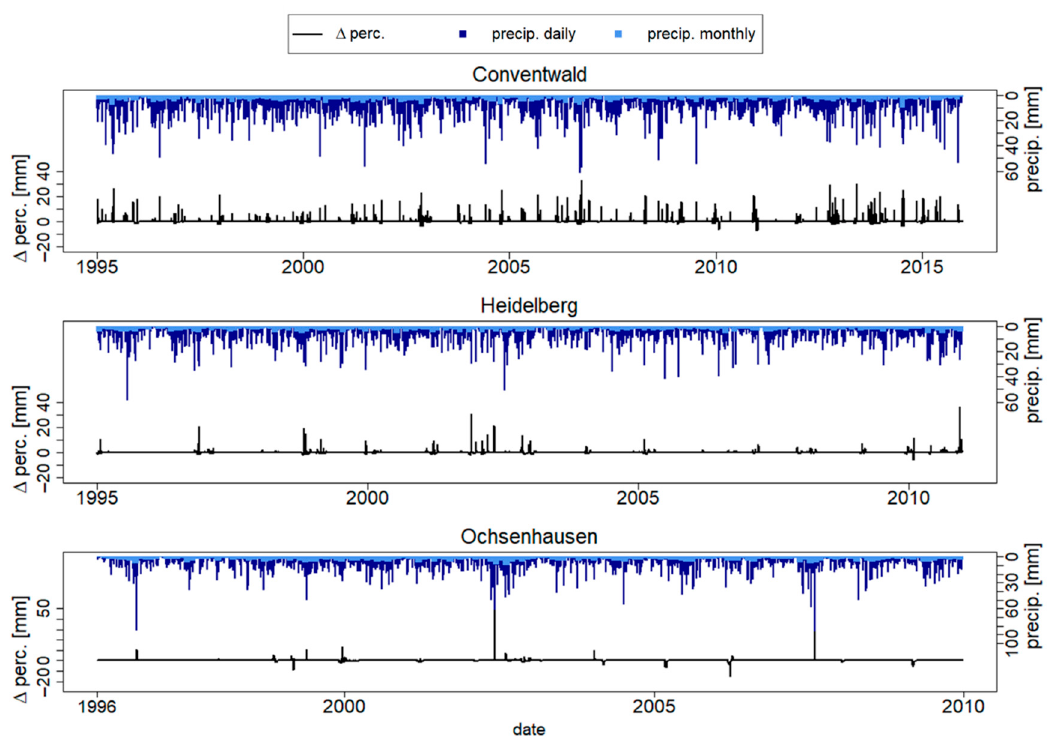
Figure A4. Variation of percolation from ER to DR ( PC ) due to daily or monthly calculation resolution, where ∆ perc. (mm × day − 1 ) is the difference between the simulated percolation with daily and monthly resolution. Monthly precipitation (precip. monthly, mm × day − 1 ) is the daily mean of monthly precipitation.